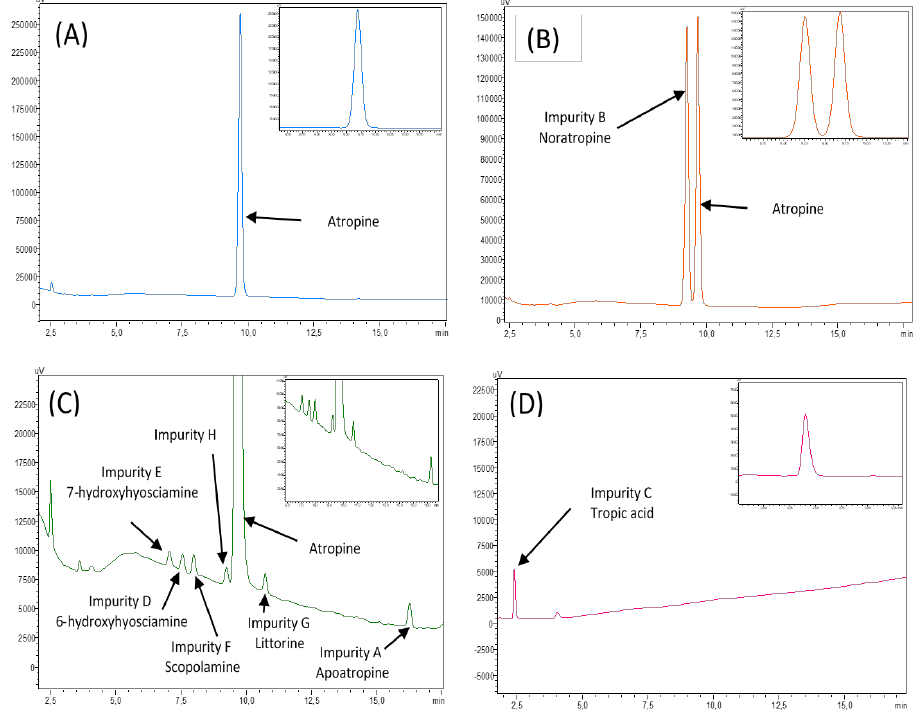
Figure 1. Reference chromatogram of a 0.1 mg/mL atropine solution at 210 nm and with diode array detector screening.